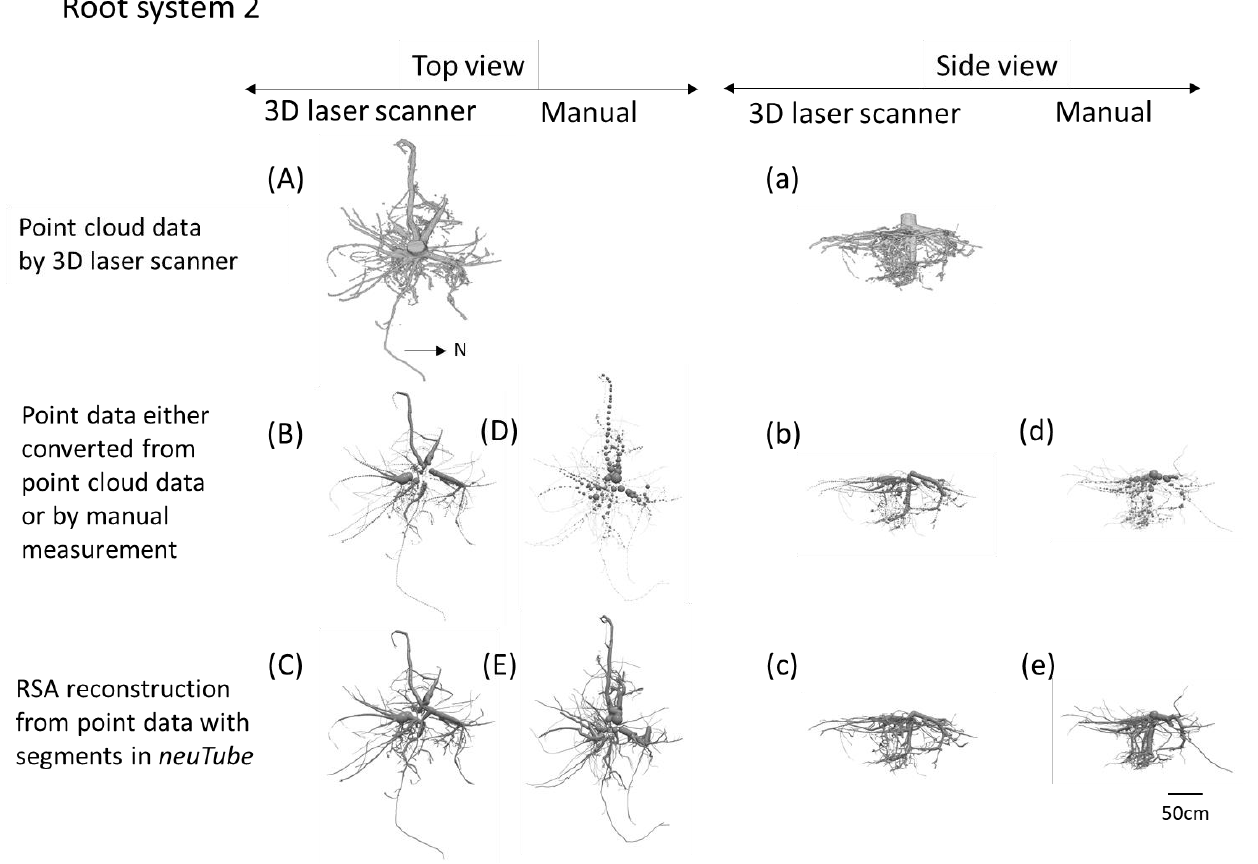
Figure 4. ( A – E ) Top and ( a – e ) side views of Root system 2 drawn from ( A , a ) point cloud data collected by 3D laser scanner root point data; ( B , b ) converted from point cloud data; ( D , d ) gathered by hand; and ( C , E , c , e ) RSA reconstructed by neuTube software.